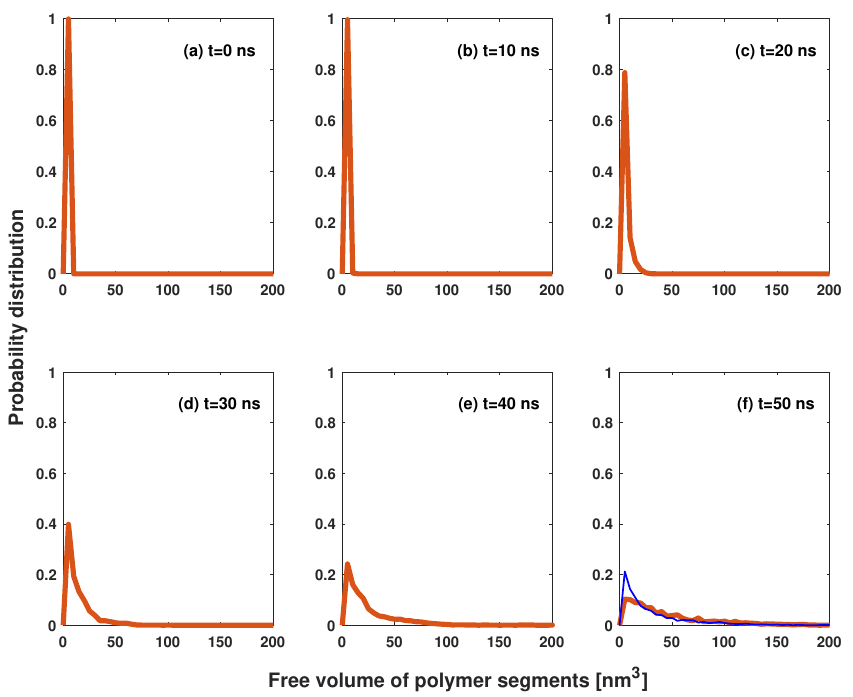
Figure 5. Free volume distribution for polymer segments. The red solid lines are the data at a start-up pressure of 30 MPa; and the blue thin line in panel (f) is the data at 34 MPa start-up